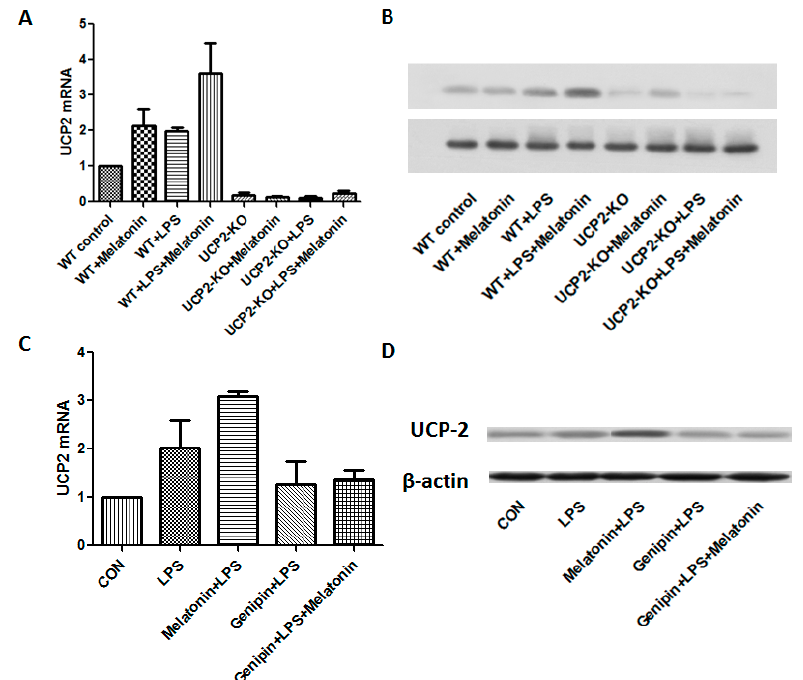
Figure 3. Effect on UCP2 expression in the animal heart tissues and in vitro cell culture. Panel ( A ): Effect on UCP2 mRNA expression in the heart tissues. Vertical axis: Expression of mRNA; horizontal axis: Different treatment groups of the animals. Panel ( B ): Representative image of immunobloting of UCP2 in the heart tissues. Panel ( C ): Effect on UCP2 mRNA expression in the AC16 cells following various treatments. Vertical axis: expression of mRNA; horizontal axis: different treatment. Panel ( D ): Representative image of immunobloting of UCP2 in the cultured AC16 cells under various treatments.